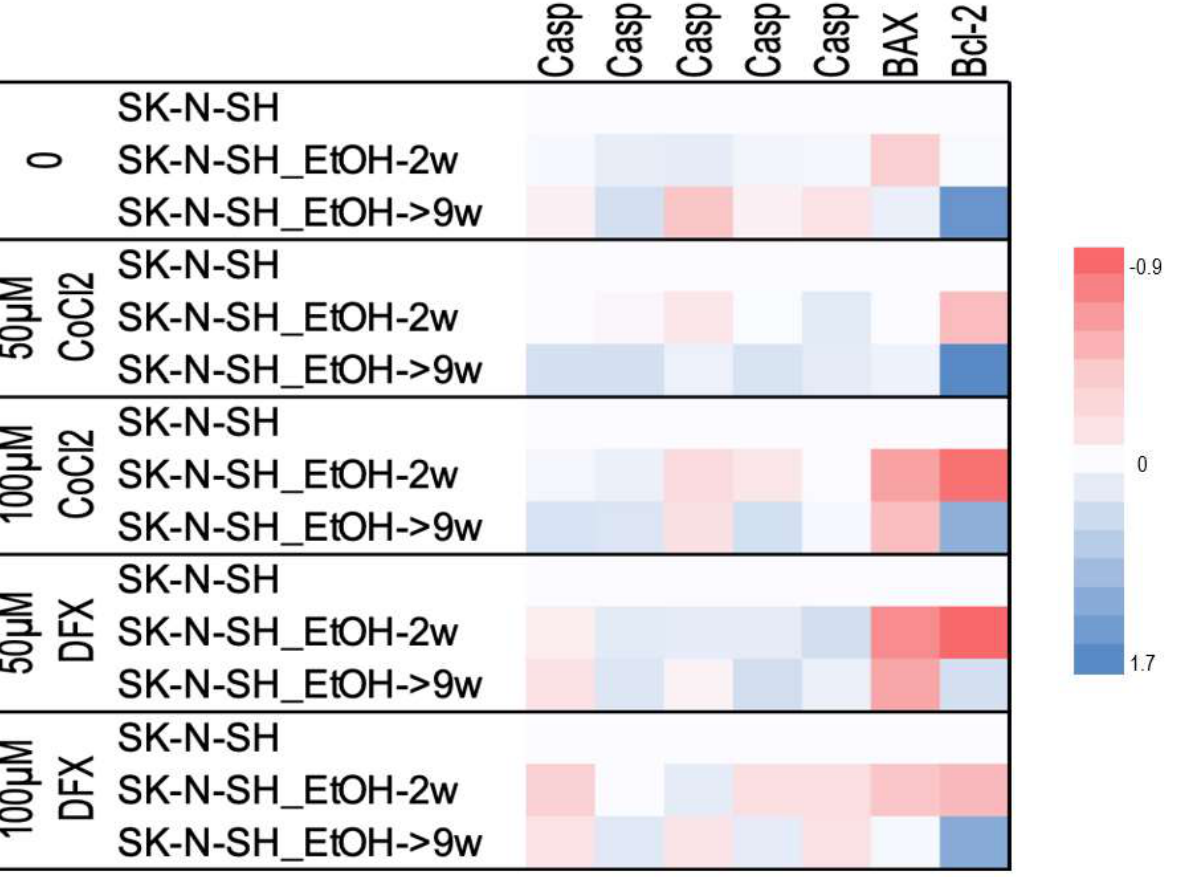
Figure 4. Heatmap showing the levels of apoptotic gene expression in ethanol-exposed and non- exposed cells treated with hypoxic agents. Each numerical data was graphically represented using warm colors for low-value data points and cool colors representing high-value data points.